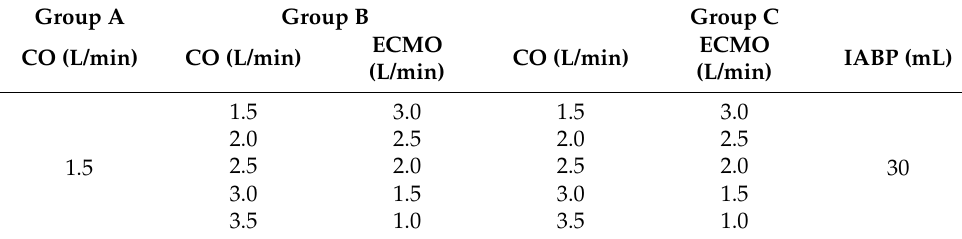
Table 1. The group of numerical